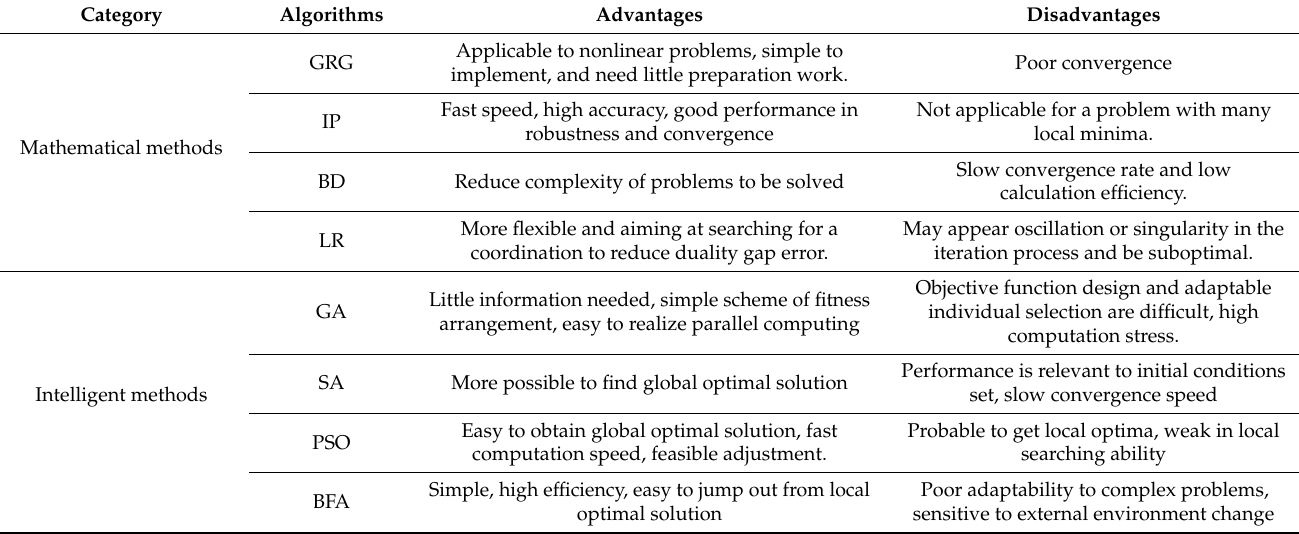
Table 1. Comparisons of common optimization